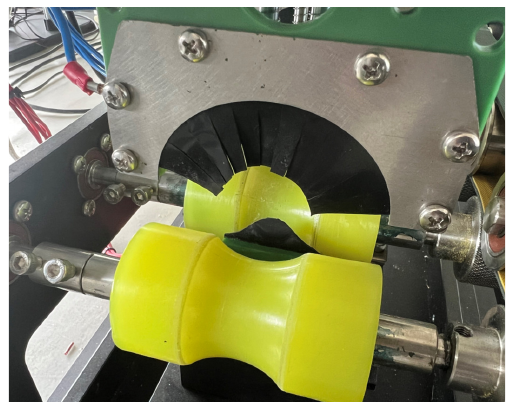
Figure 9. Real figure of